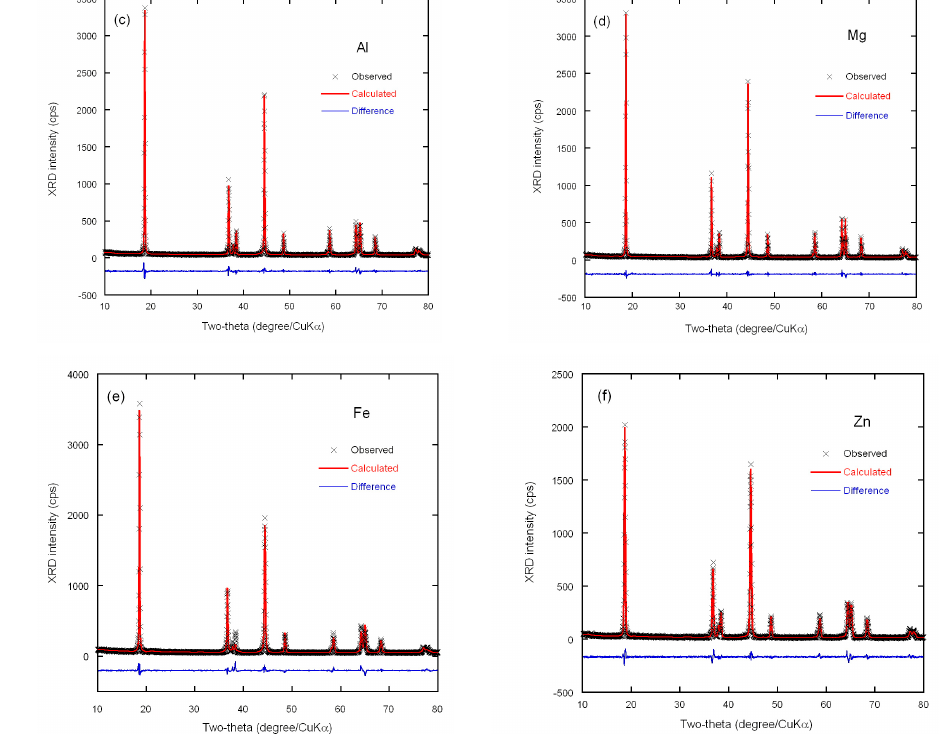
Figure 1. X-ray di ff raction (XRD) patterns ( a ) and Rietveld refinements ( b – f ) of undoped Li(Ni 1 / 3 Mn 1 / 3 Co 1 / 3 )O 2 and doped Li(Ni 1 / 3 Mn 1 / 3 Co 1 / 3 ) 1 − x M x O 2 ( x = 0.06, M = Fe, Al, Mg, Zn), respectively. Cross marks are experimental data and solid lines (in red) are calculated diagrams. The curve at the bottom (in blue) is the di ff erence between the calculated and observed intensities. Table 1. Results of Rietveld refinements for undoped Li(Ni 1 / 3 Mn 1 / 3 Co 1 / 3 )O 2 and